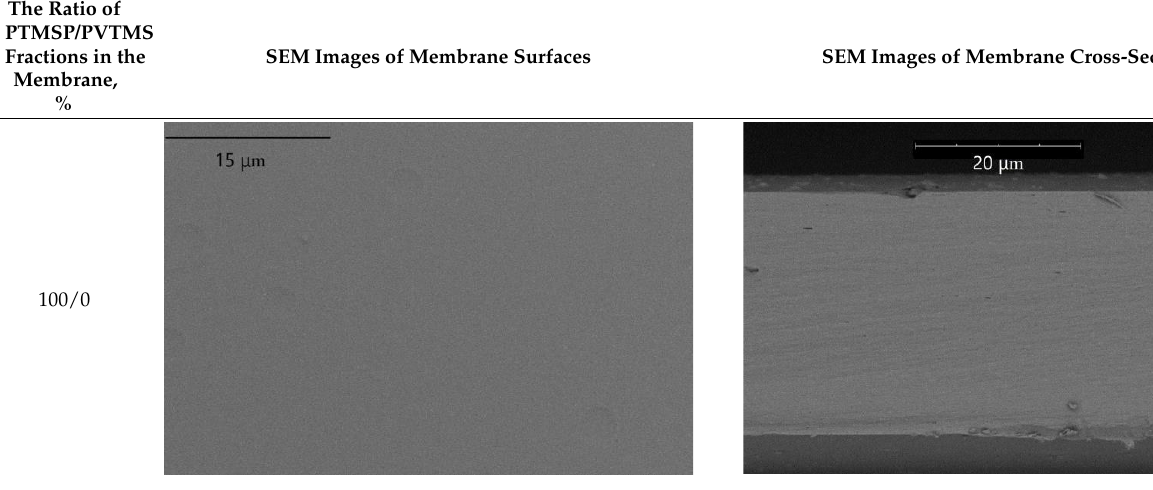
Table A1. Micrographs of the surface and cross-section of the studied